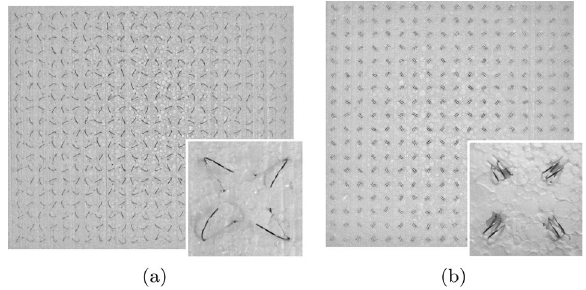
FIG. 9. Fabricated metasurfaces of (a) single-turn and (b) double-turn helices comprising, respectively, 480 and 324 elements embedded in plastic foam.